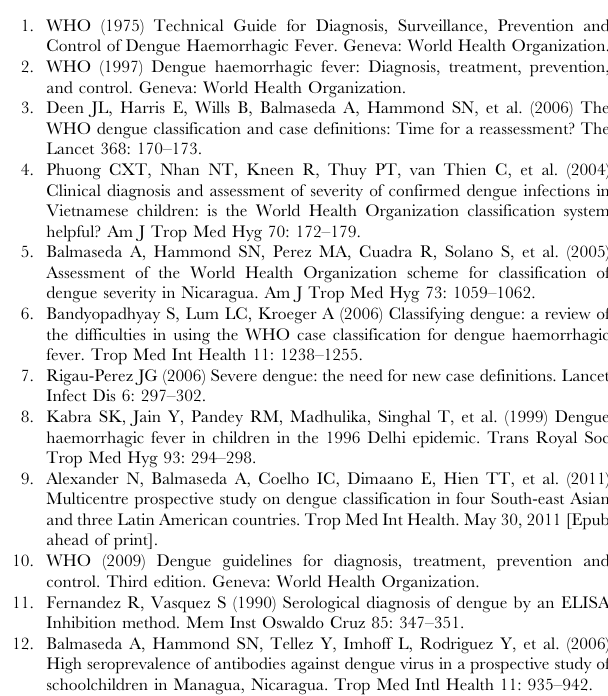
Table S2 Association between ultrasonographic